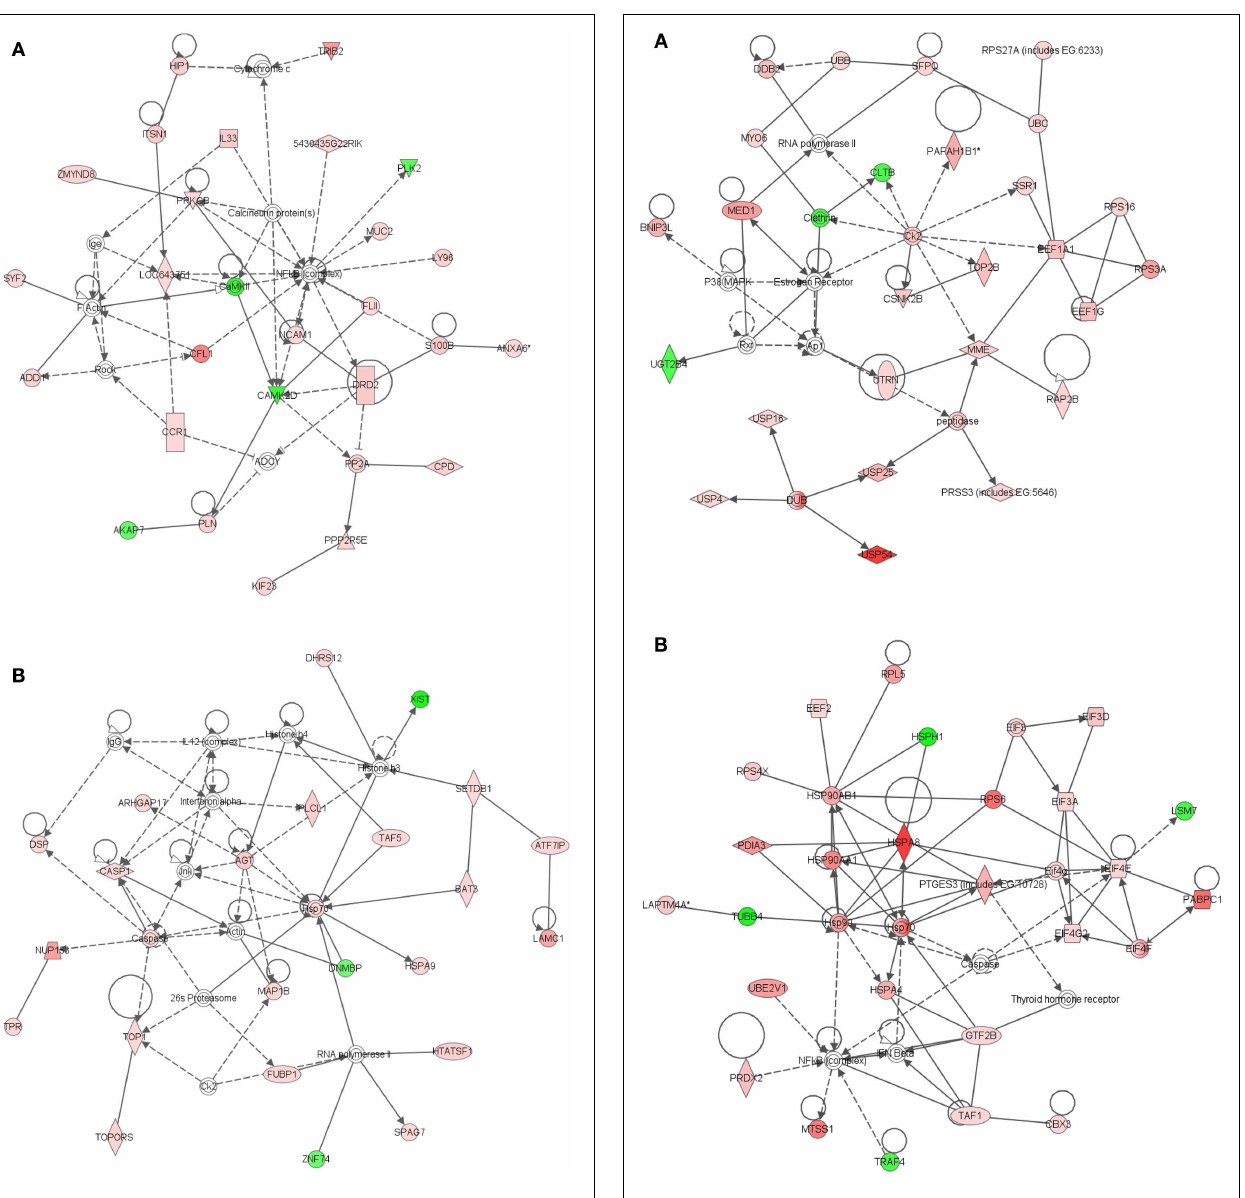
2006). SAT2 is the target of DNA methyltransferase 1 ( DNMT1 ) and an epigenetic modifier, whose methylation status may serve as a marker for cancer prognosis (Jackson et al., 2004).